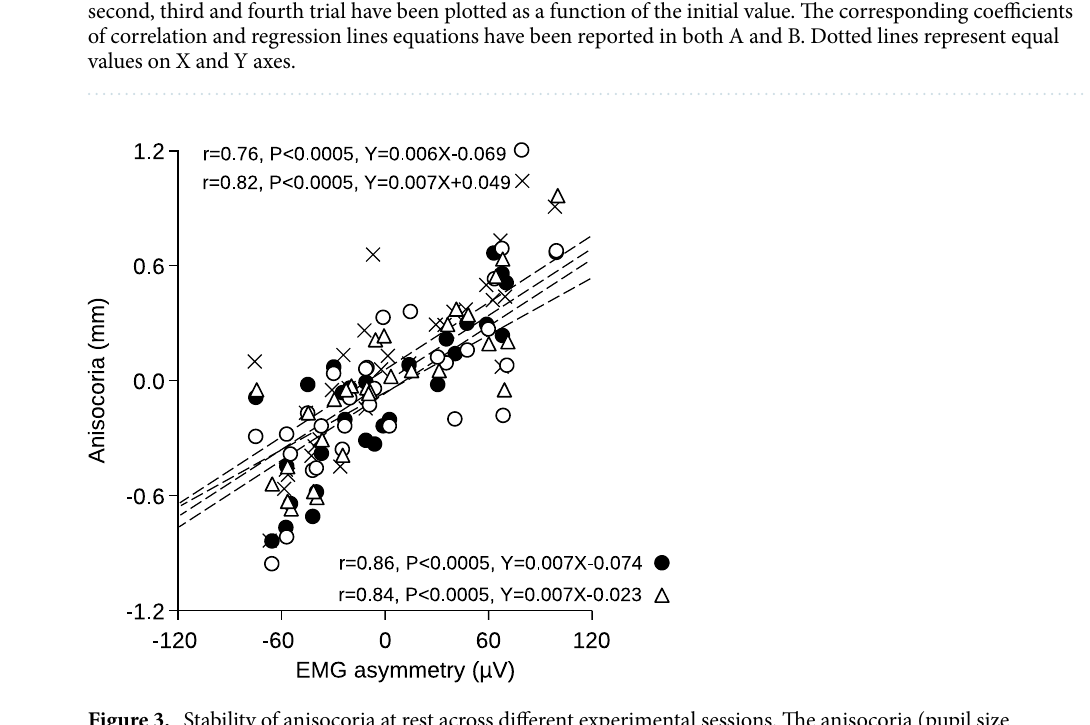
Figure 3. Stability of anisocoria at rest across different experimental sessions. The anisocoria (pupil size difference: left–right) at rest has been recorded in four different experimental sessions (trials) with the arches apart and the masticatory muscle relaxed. Values obtained in the different trials have been plotted as a function of the EMG asymmetry (left–right) of masseter muscles observed during clenching. Dots: trial 1, circles: trial 2, crosses: trial 3, triangles: trial 4. The dotted lines correspond to the regression lines evaluated for the different trials, whose equations are reported in the